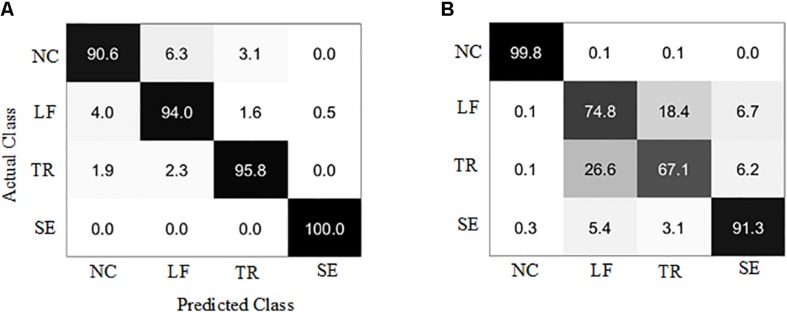
Confusion matrix of the trunk compensation detection models. (A) Healthy group. (B) Stroke group. NC, no compensation; LF, lean-forward; TR, trunk rotation; SE, shoulder elevation.